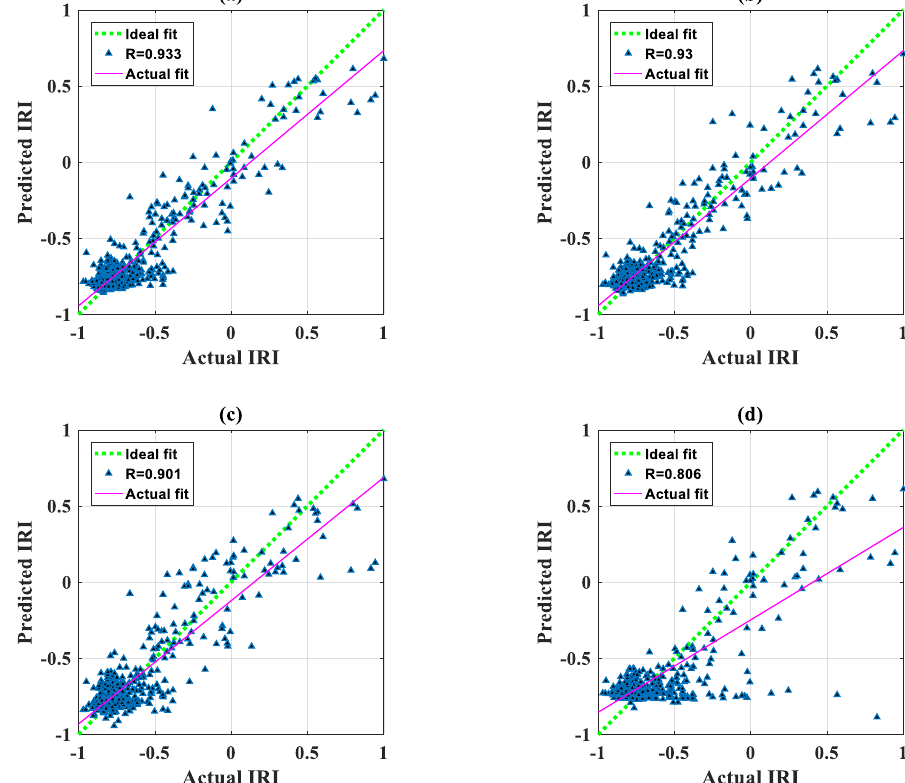
Figure 7. Correlation results analysis of the models using the training dataset: ( a ) PSOANFIS, ( b ) GANFIS, ( c ) FAANFIS, ( d ) ANN.